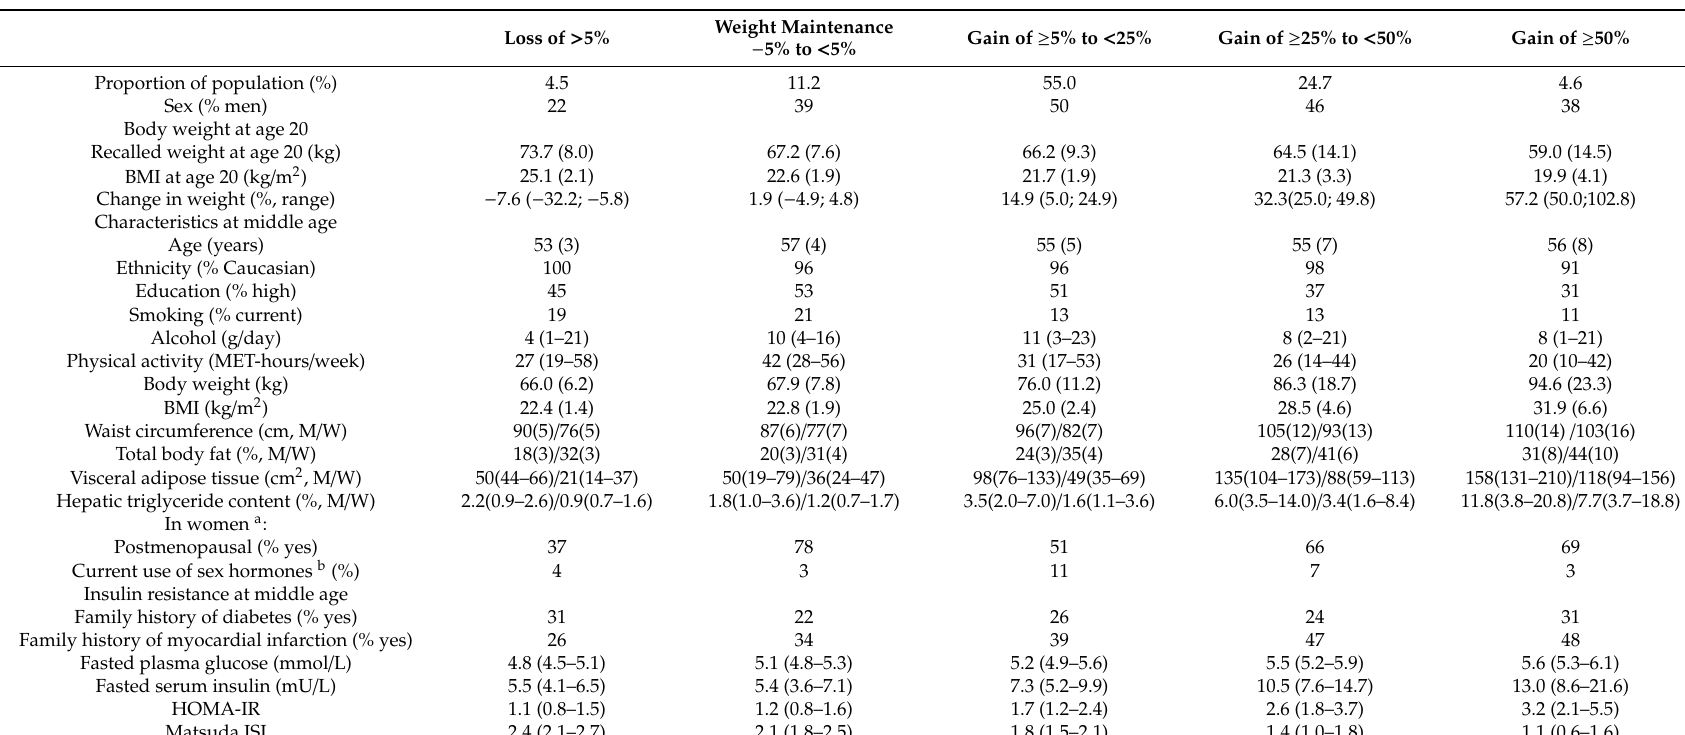
Table 1. Characteristics of participants of the Netherlands Epidemiology of Obesity (NEO) study, aged 45 to 65 years, with measurements of visceral adipose tissue and hepatic triglyceride content by magnetic resonance imaging and spectroscopy, stratified by adult weight change ( N =